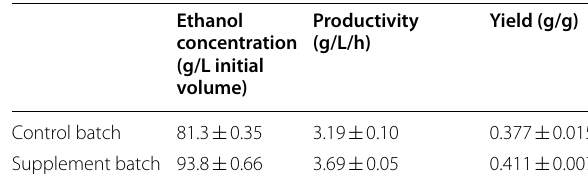
Table 2 Comparison of fermentation process between